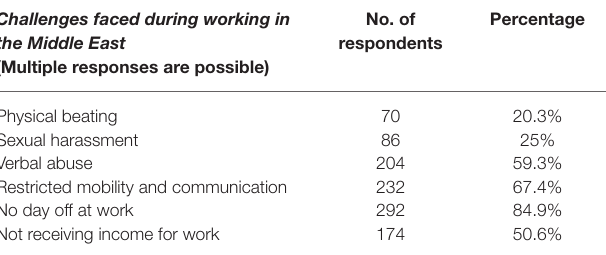
TABLE 3 | Challenges faced by female return migrants while working in the Middle